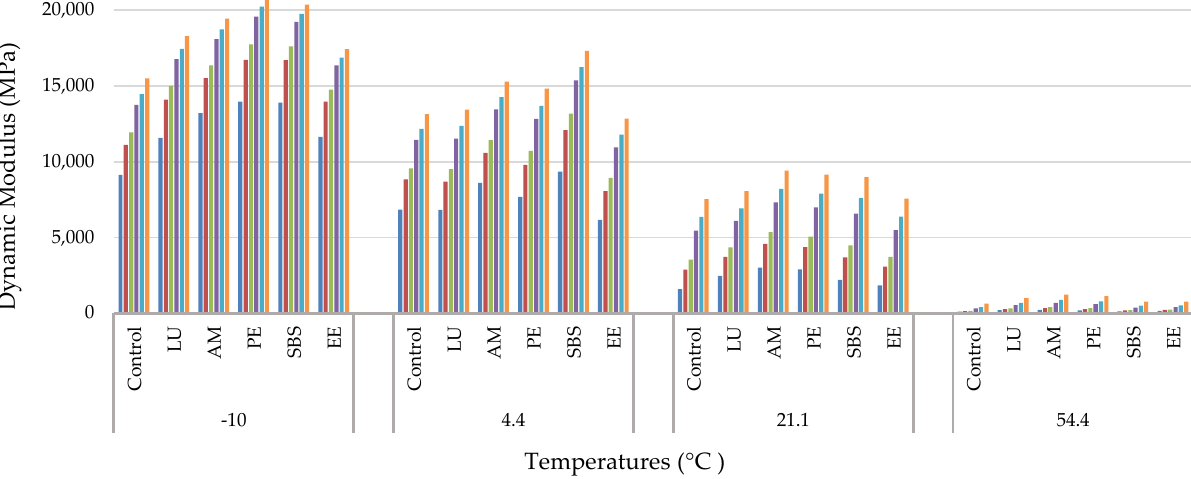
Figure 9. Phase angle versus frequencies at different temperatures. Generally, the dynamic moduli values of all modified asphalt mixtures increased by decreasing the temperature, and they were increased by increasing the frequency. While phase angle increased by increasing the temperature, it was decreased by increasing the frequency. This is because as the temperature increases or decreases, the viscosity of the